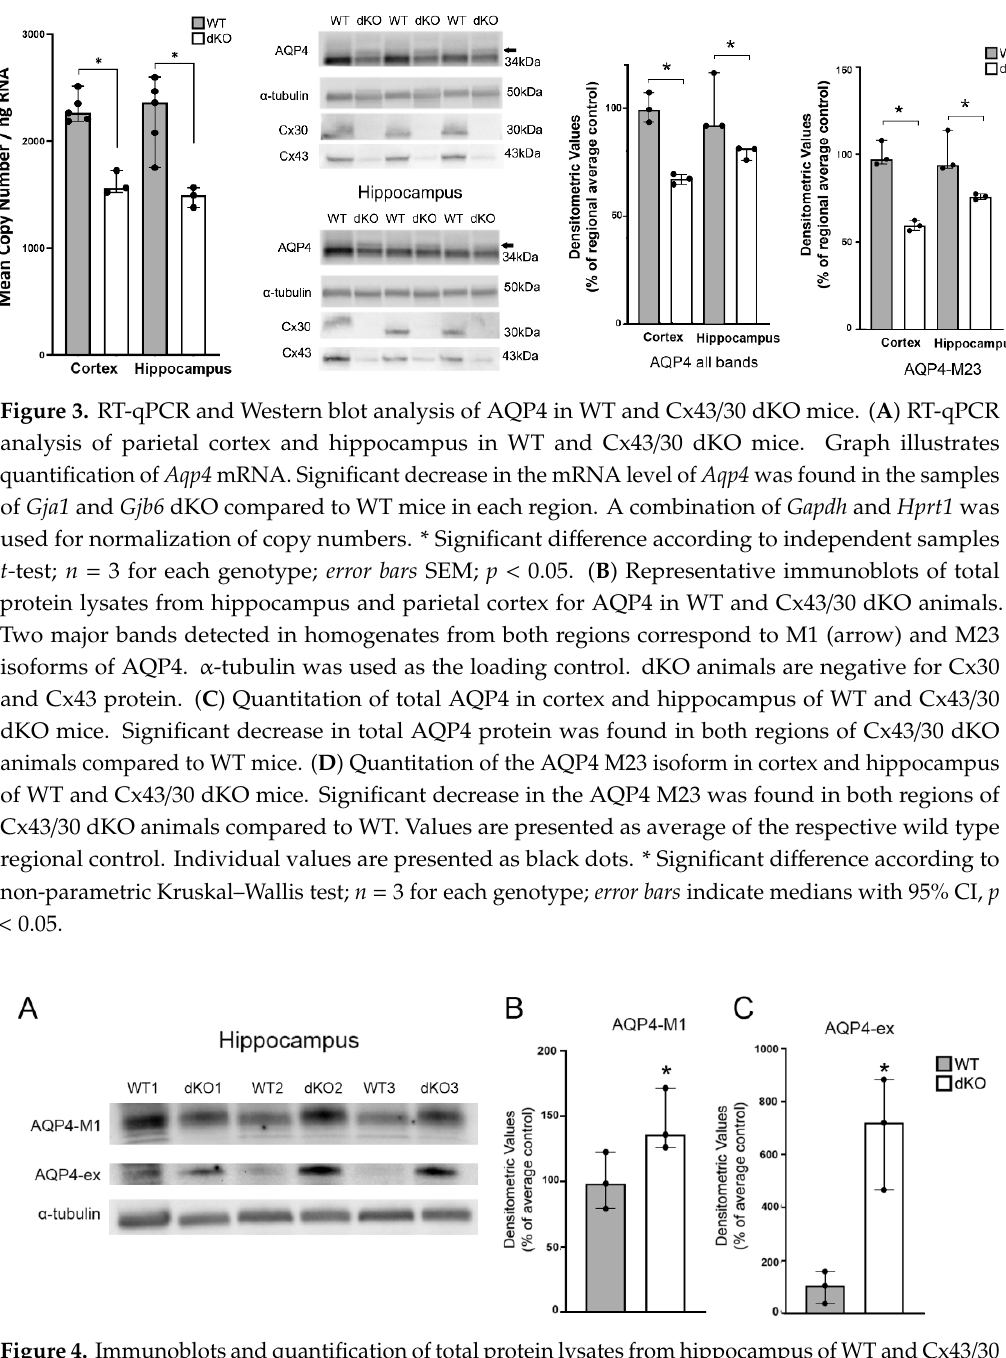
Figure 4. Immunoblots and quantification of total protein lysates from hippocampus of WT and Cx43 / 30 dKO mice. ( A ) Representative immunoblots of total protein lysates from hippocampus for AQP4-M1 and AQP4-ex in WT and Cx43 / 30 dKO animals. α -tubulin was used as the loading control. ( B , C ) Graphs illustrate densitometric analysis of AQP4-M1 and AQP4-ex immunoblotts of hippocampus of WT and Cx43 / 30 dKO mice. A significant increase in AQP4-M1 and AQP4-ex protein isoforms was found in Cx43 / 30 dKO animals compared to WT. Values are presented as average of the respective wild type regional control *significant di ff erence with non-parametric Kruskal–Wallis test; n = 3 for each genotype; error bars medians with 95% CI, p < 0.05.